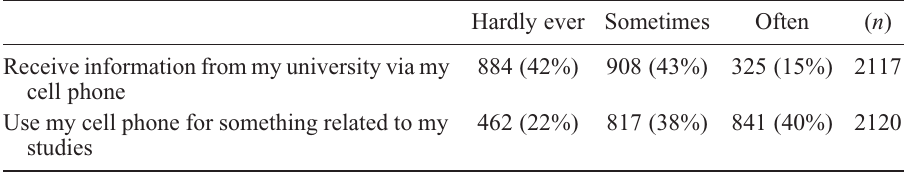
Table 2. Academic use of cell phones.